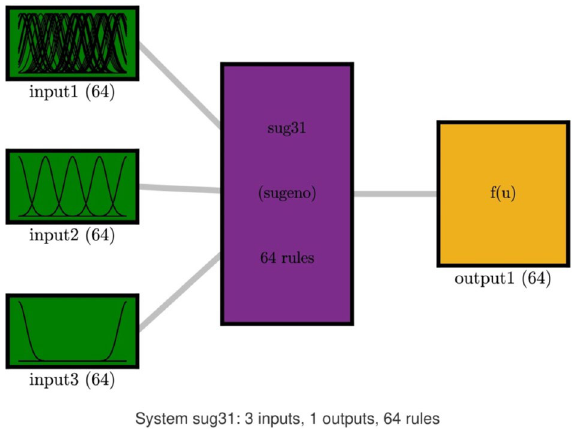
Figure 3. FIS system schematics when number of input is 3, and number of rule for each input membership function is